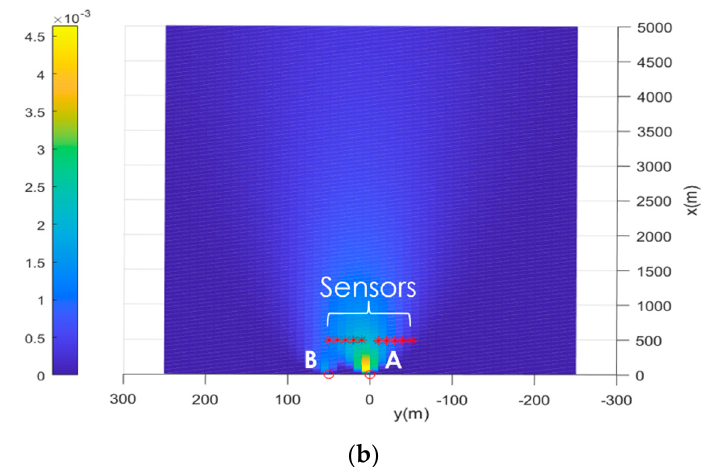
Figure 3. Concentrations of leaking hazardous gas with unit g/m 3 over the spatial plane of z = 9 m when the strengths of hazardous gas leakages are Q A = 7.5 and Q B = 2.5 with unit g/s. ( a ) 3D view. ( b ) Bird’s eye view. Table 2. Hazardous-Gas-Leaking Scenarios Taken into Account for Multi-Sensor Data-Driven Model